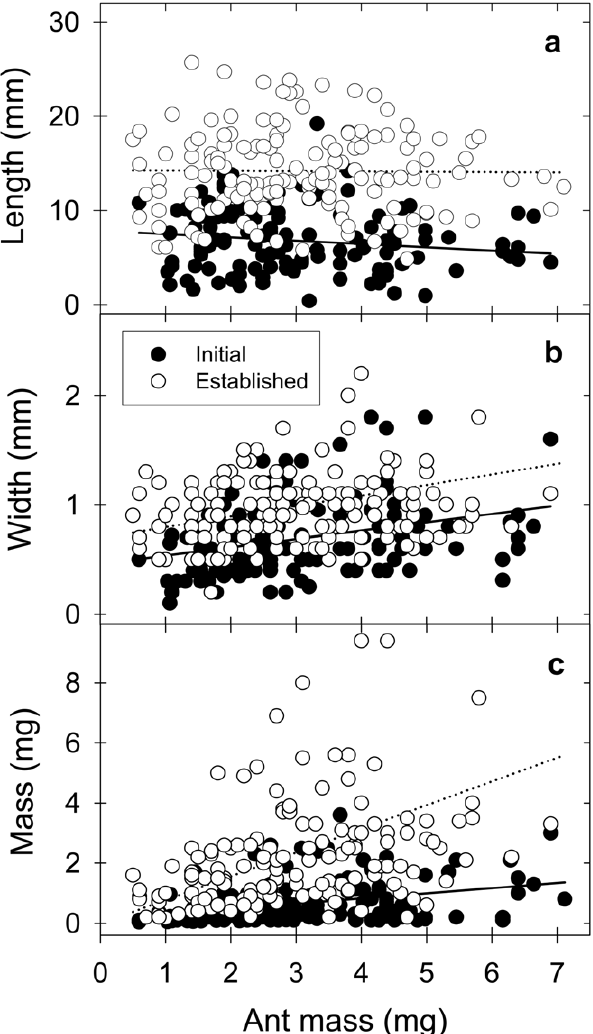
Figure 3. Load-size determination by foraging workers in the field. Length ( A ), width ( B ) and mass ( C ) of the grass fragments cut by different-sized foragers in the field, at both the initial and established foraging